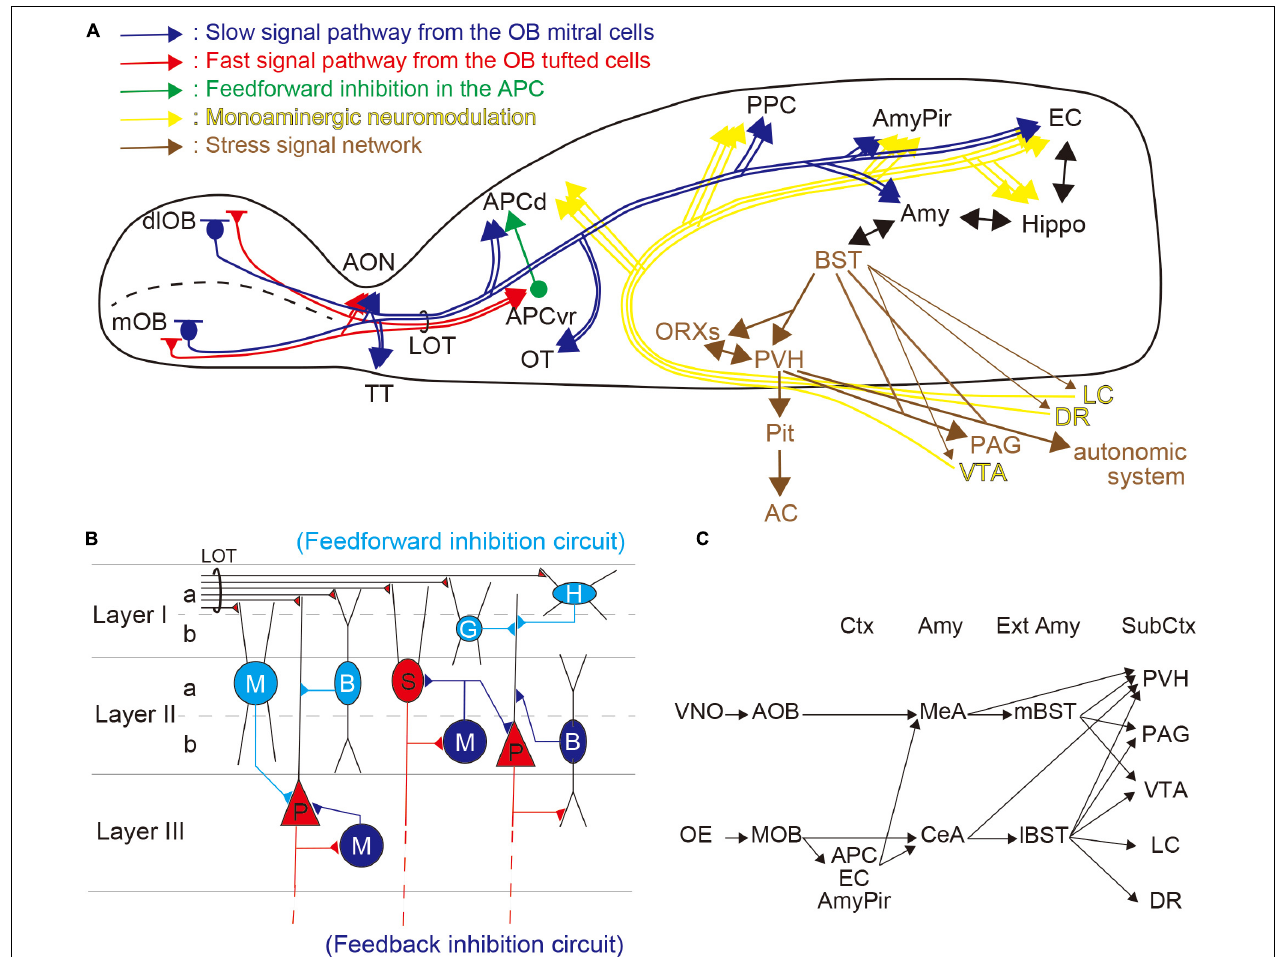
FIGURE 1 | Olfactory information processing and stress-related networks. (A) Overview of the regulation of the odor–stress response. Distinct olfactory bulb (OB) projection neurons are shown in red [tufted cells (TCs)] and blue [mitral cells (MCs)] lines, and show fast and slow pathways, respectively. TCs project to the anterior olfactory nucleus (AON) and the ventrorostral part of the anterior piriform cortex (APCvr). MCs innervate the AON, the olfactory tubercle (OT), the APCd, the posterior piriform cortex (PPC), the amygdalopiriform transition area (AmyPir), the entorhinal cortex (EC), and the amygdala (Amy). Feedforward inhibitory circuit from the APCvr to the APCd is shown as a green line. Stress-related networks are illustrated in brown; from the bed nucleus of the stria terminalis (BST), the information passes to the hypothalamus (PVH and ORXs) where it can activate the hypothalamic–pituitary–adrenal (HPA) axis. Many brainstem regions, including the periaqueductal gray (PAG) and autonomic system, receive information from the BST and hypothalamus. The yellow lines show monoaminergic modulatory networks. DA projections from the ventral tegmental area (VTA), NE projections from the locus coeruleus (LC), and serotonin (5-HT) projections from the dorsal raphe (DR) are distributed widely in the brain. (B) Inhibitory pathways in the piriform cortex (PC). In the PC, olfactory information from the OB is obtained via the lateral olfactory tract (LOT). Horizontal cells (H), neurogliaform cells (G), bitufted cells (B), and multipolar cells (M), which are inhibitory interneurons in the superficial layer (illustrated in light blue), have feedforward connections to projection neurons [semilunar cells (S) and pyramidal cells (P); illustrated in red] in the PC. Inhibitory cells in mid to deep layers (B and M; illustrated in blue) feedback onto S and P cells. (C) Putative networks for odor-induced stress responses. The accessory olfactory system (AOS) from the vomeronasal organ (VNO) provides inputs to the extended amygdala (Ext Amy) via the medial amygdala (MeA). In contrast, the main olfactory system (MOS) from the olfactory epithelium (OE) provides inputs to the Ext Amy directly from the central amygdala (CeA) and indirectly via olfactory cortices, including the APC, EC, and AmyPir. Both the Amy and Ext Amy have projections to subcortical regions (Sub Ctx) including the PVH, PAG, VTA, LC, and